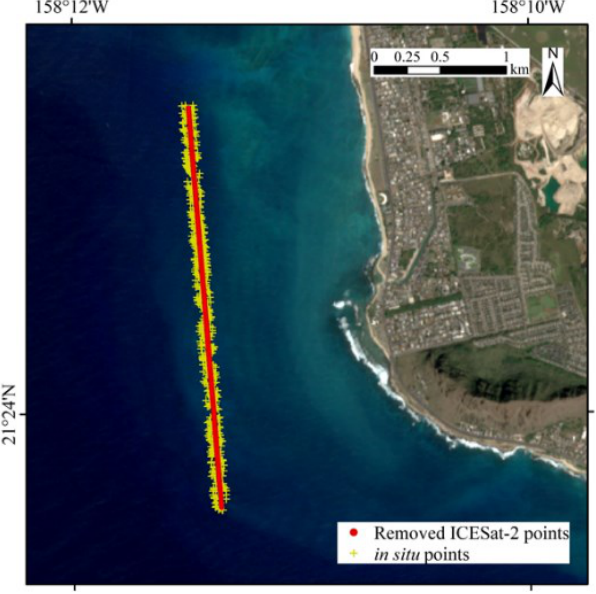
Figure 12. Local study area around the missing data. The red points are the missing data that were manually removed, and the yellow “ + ” are the in situ water depth points within 50 m around the missing data.